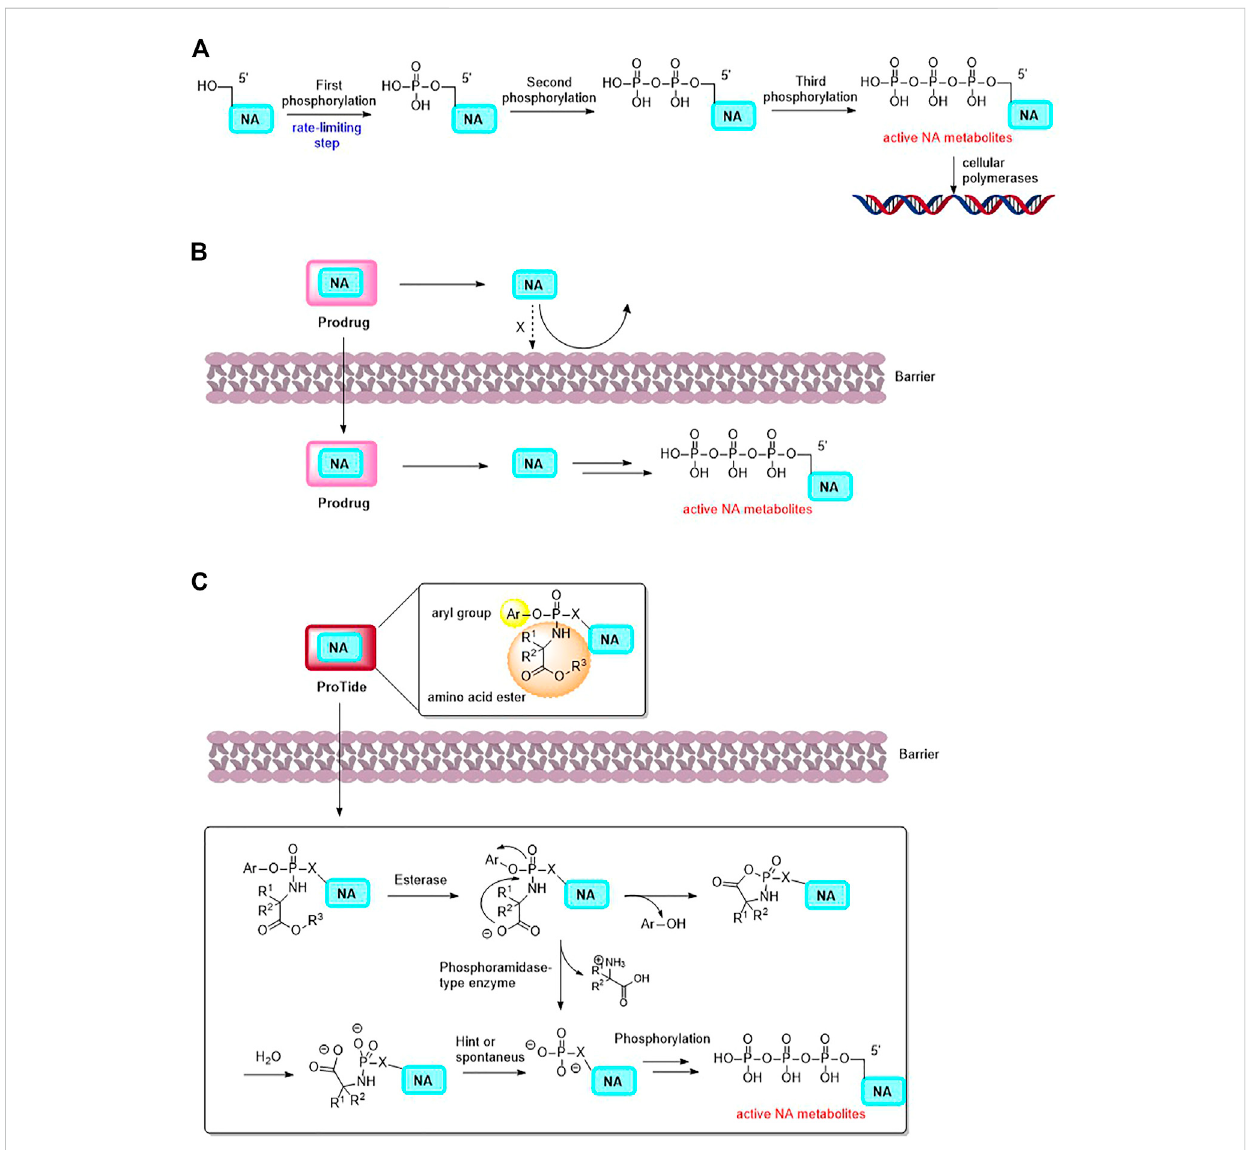
FIGURE 1 (A) TheactivationmechanismofNA(NA:nucleosideanalogue). (B) TheconceptofProdrug.Prodrugisabletodelivertheparentdrug(NA)tospeci fi c tissue. (C) Postulated mechanism of the mechanism of ProTides to release NA and its active